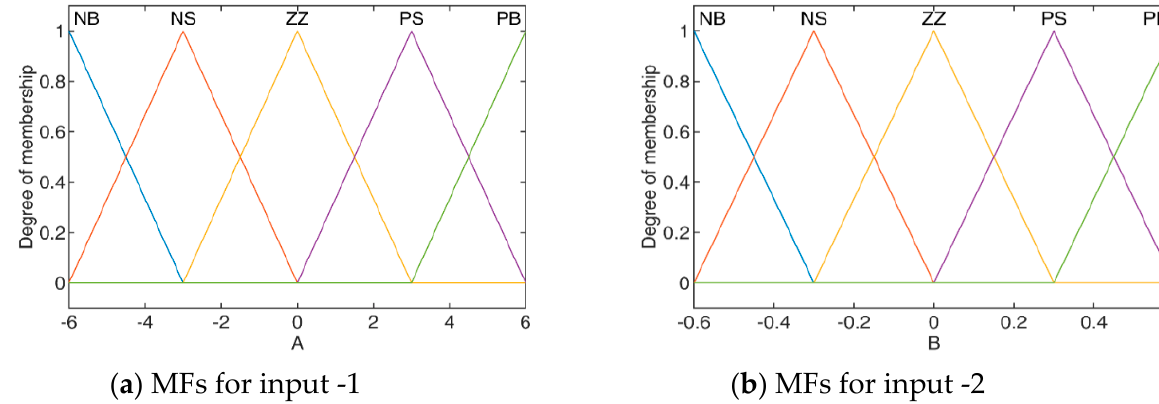
Figure 6. Input MFs of fuzzy system. Table 1. Rule of Fuzzy